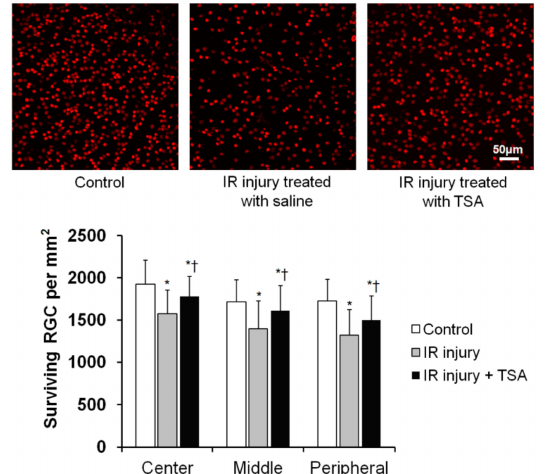
Figure 6. The e ff ect of TSA on RGC survival in ischemic retinas. Retinal flat mounts are shown for the control, saline-treated ischemic retina, and TSA-treated ischemic retina groups ( n = 10 retinas / group). Quantitative analysis of RGC survival are also shown as graph. Scale bars, 50 µ m. * p < 0.05 compared to the control group. † p < 0.05 compared to the saline-treated IR injury group. All comparisons were performed using one-way ANOVA with post hoc Bonferroni’s